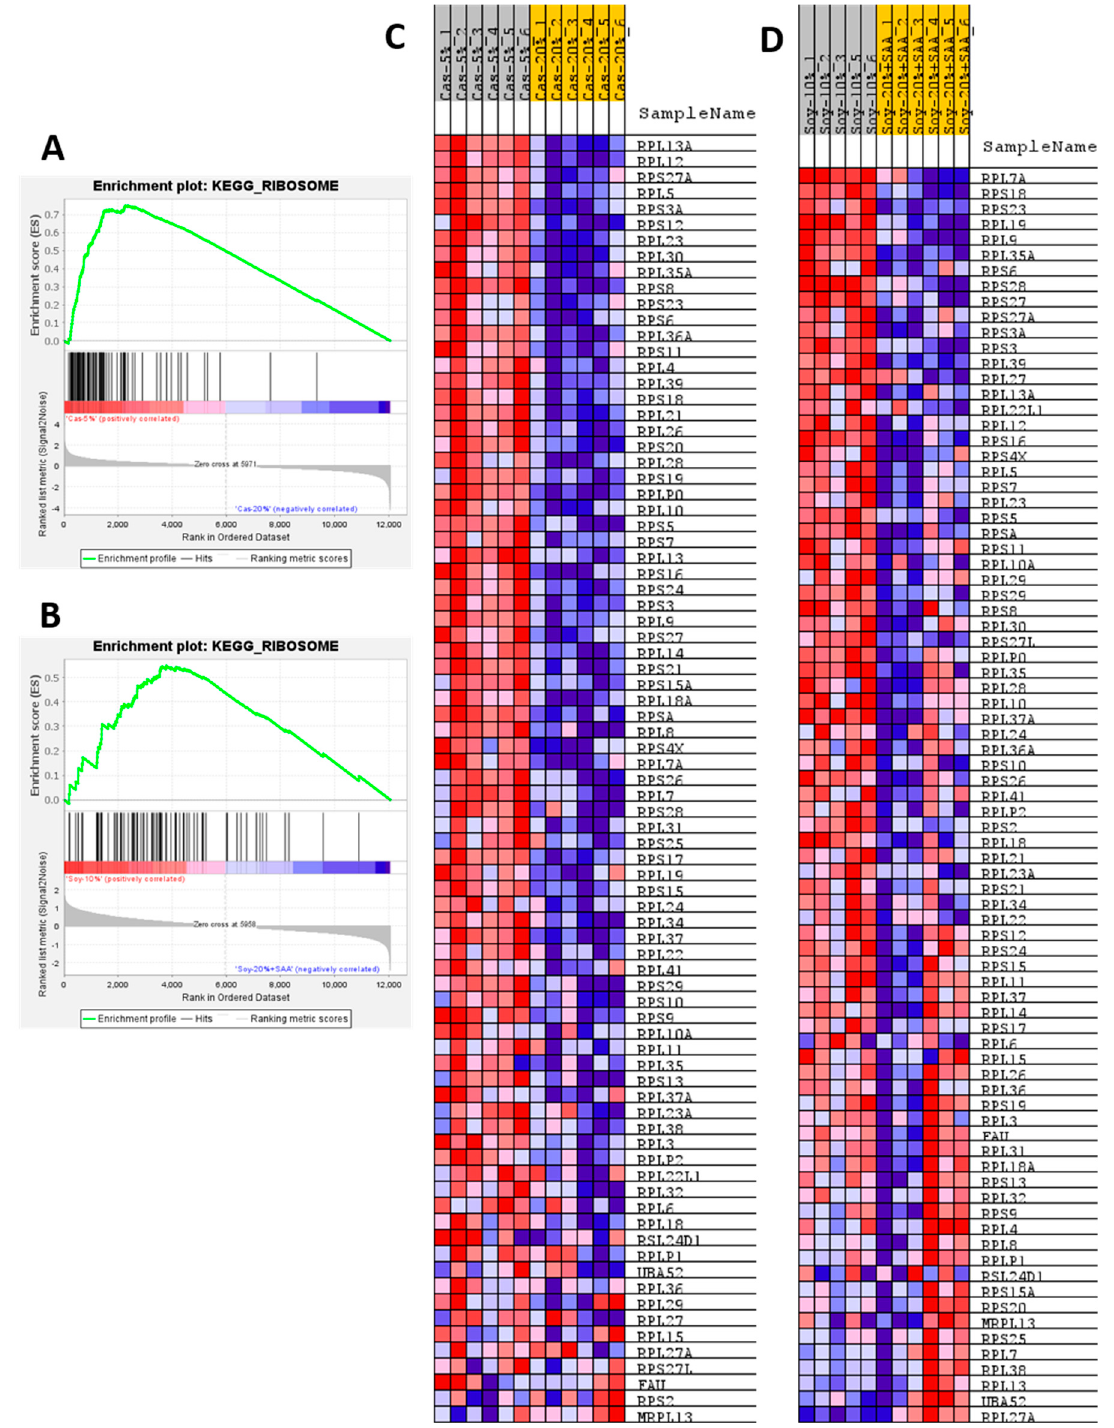
Figure 4. Gene set enrichment analysis (GSEA) of hepatic gene expression in mice fed sulfur amino acid-matched control diets formulated from casein (Cas-20%) or soy (Soy-20% + SAA), and sulfur amino acid-matched protein restricted diets formulated from casein (Cas-5%) or soy (Soy-10%). The enrichment plots and corresponding heat maps are shown for the top-scoring KEGG Ribosome gene set for the Cas-5% to Cas-20% ( A , C ) and Soy-10% to Soy-20% + SAA comparisons ( B , D ). Enrichment was computed as described in the Material and Methods and enrichment plots were generated to visualize the individual contributions of pathway genes to pathway enrichment. Accompanying heat maps present the normalized enrichment scores for individual genes within the gene set [blue = downregulation, red = upregulation, gray = not signif- icant (FDR > 0.1)].